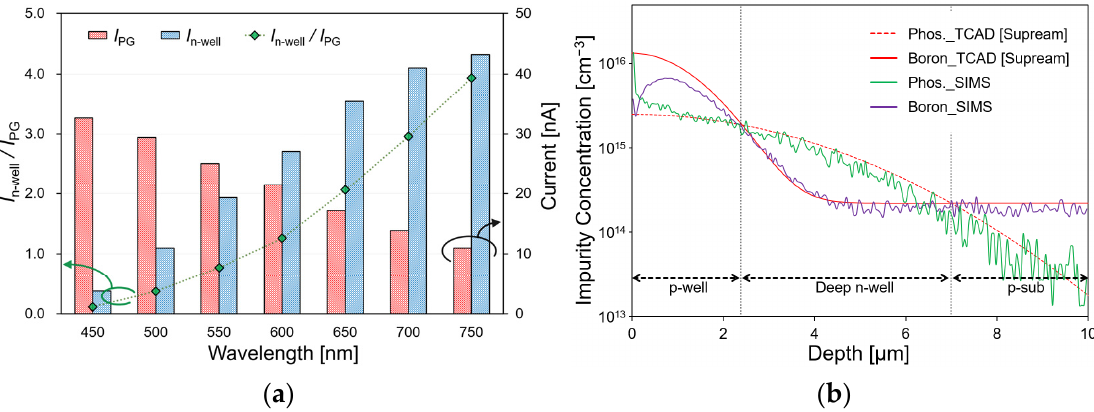
Figure 3. ( a ) Simulation results of the current characteristics of the sensor; ( b ) simulation results by TCAD and the analysis results by SIMS of the impurity concentration of the fabricated sensor.